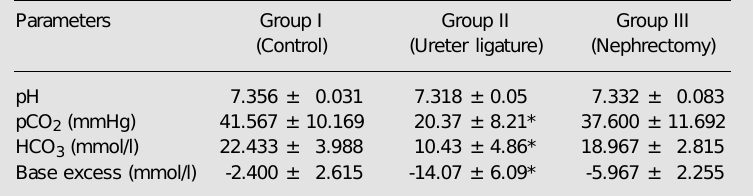
Table 2. Arterial gasometry of rats with renal and postrenal failures.